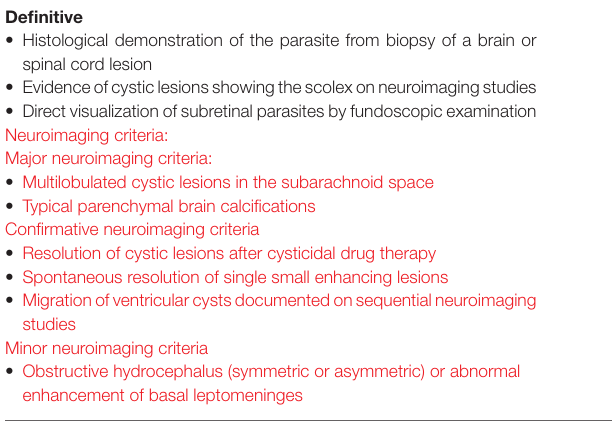
TABLE 1 | Diagnostic criteria [derived from (20,